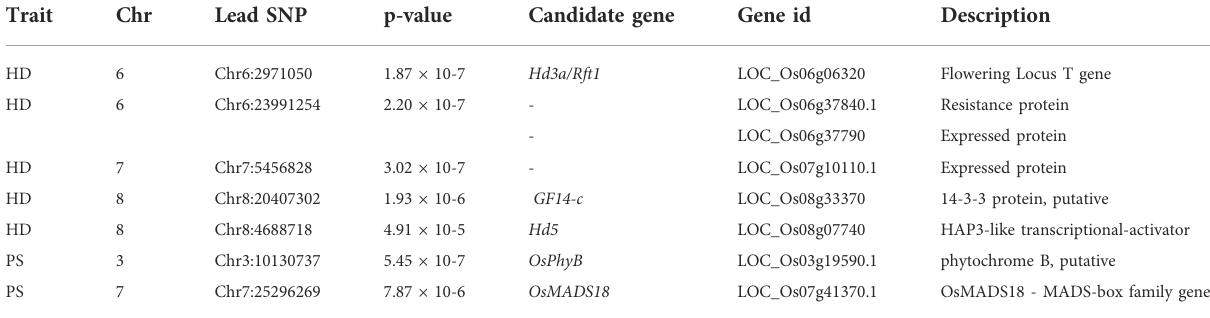
TABLE 1 Signi fi cant SNPs associated with Hd and